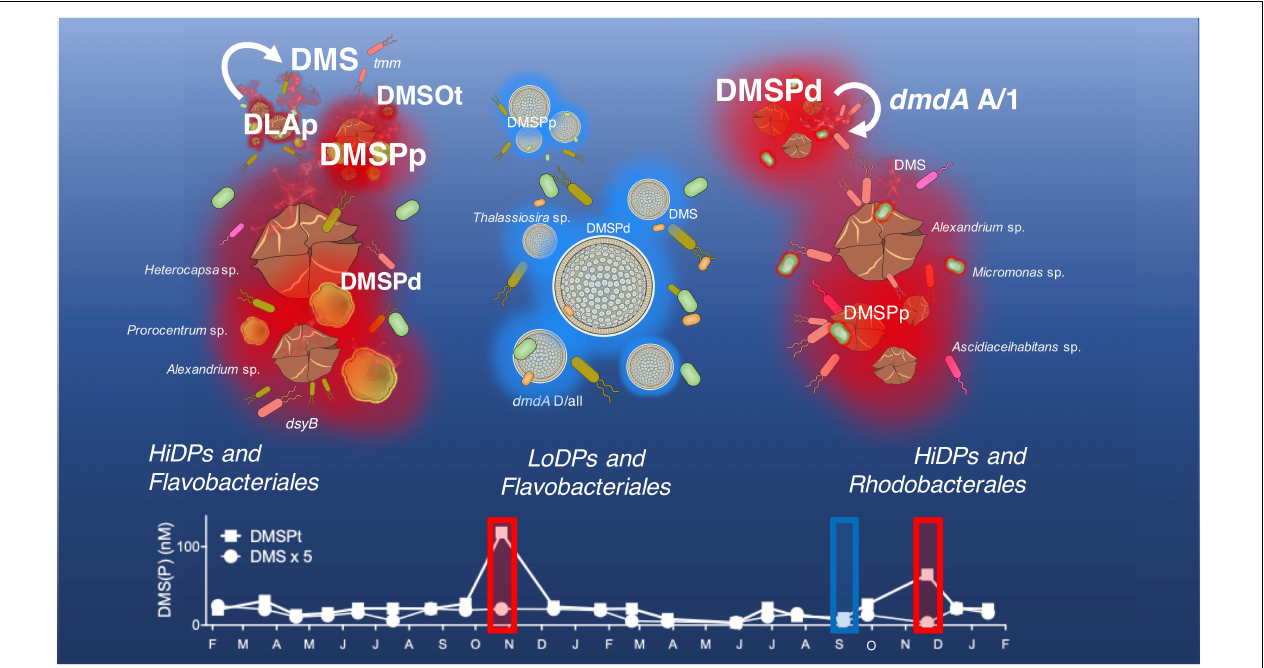
FIGURE 7 | Dimethylsulfoniopropionate (DMSP)-producing phytoplankton and associated bacterial consortia influencing DMSP cycling at Port Hacking time series in October 2017 (the left panel), September 2018 (the middle panel) and November 2018 (the right panel). Concentrations of particulate DMSP (DMSPp) are driven by the composition and DMSP-producing potential of phytoplankton present. The low-DMSP-producing phenotype (LoDP) Thalassiosira sp. produces comparatively low-DMSPp to high-DMSP-producing phenotypes (HiDP), Heterocapsa sp., Prorocentrum sp., Alexandrium sp., and Micromonas sp. Concentrations of DMSP converted by HiDPs with active DMSP lyases enzymes (DLAp) contribute to high concentrations of the volatile sulfur emission dimethyl sulfide (DMS). High concentrations of DMS are accompanied by a high relative abundance of the bacterial DMS oxidation gene ( tmm ), which may contribute to the high dimethyl sulfoxide (DMSO) concentrations observed. The amount of DMS in the surface water at Port Hacking can be constrained by shifts in the genes encoding the DMSP demethylase pathway ( dmdA A/1, dmdA D/all), including Roseobacter strains, like Ascidiaceihabitans